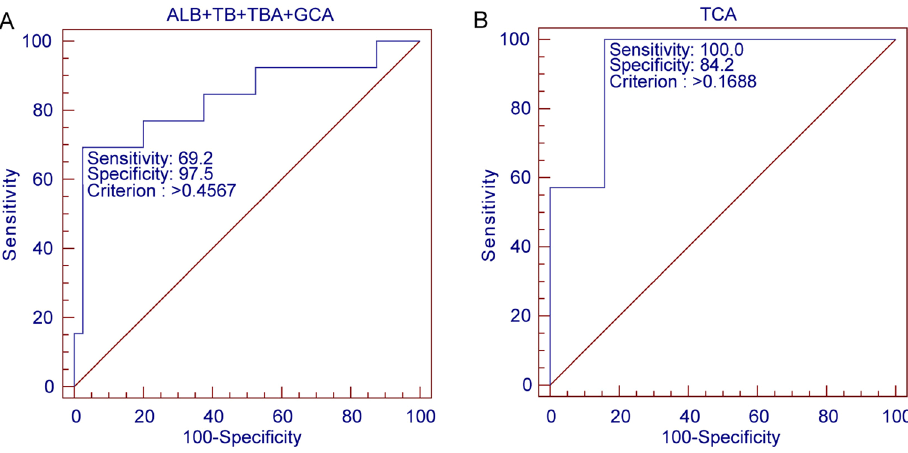
Figure 5. Receiver operating characteristic curves of TBA + GCA percentage of TBA + ALB + TB for the prediction of PTB in EICP ( A ). Receiver operating characteristic curves of TCA percentage of TBA for the prediction of PTB in LICP ( B